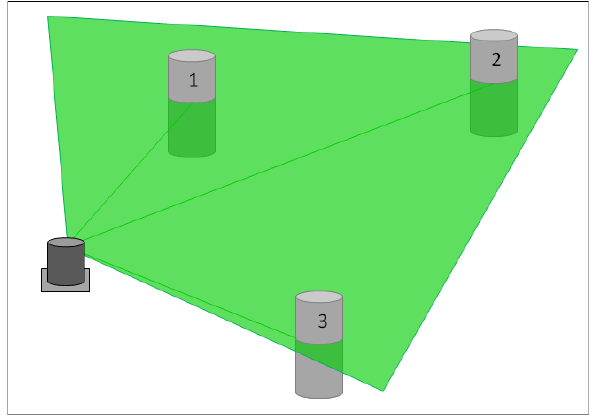
Figure 1: Laser scanner scanning in one horizontal plane.